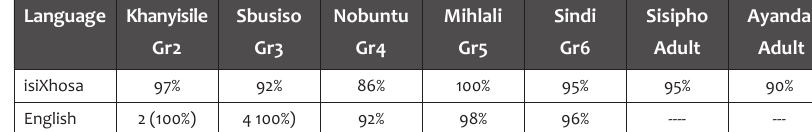
Table 6: Percentage of Miscues that have high graphophonics similarity with the Expected